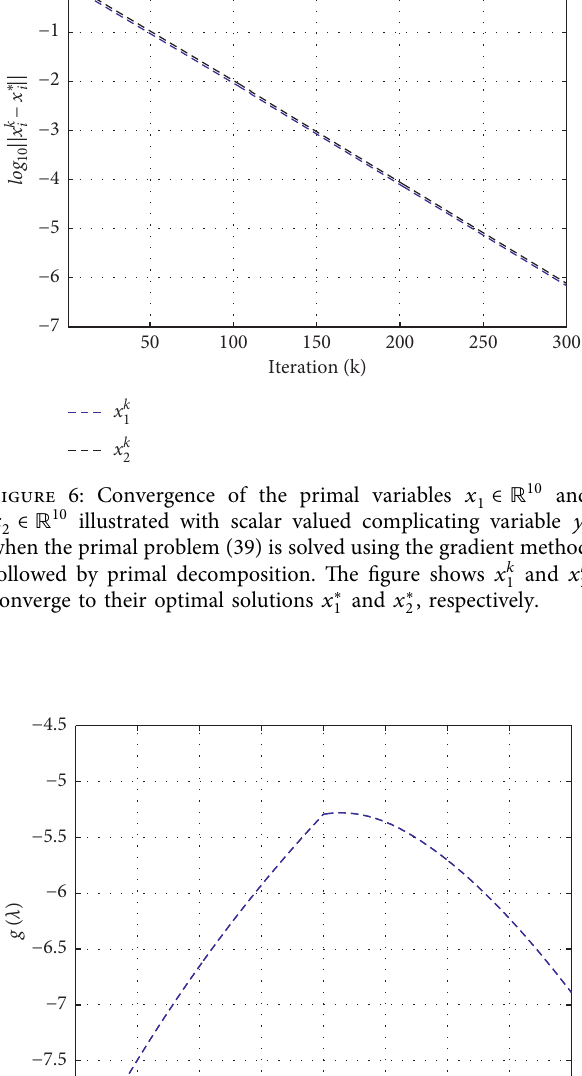
Figure 7: Dual function corresponding to problem (41). The figure reveals the concavity and nondifferentiability of g ( λ ) . λ ∗ attains around λ �